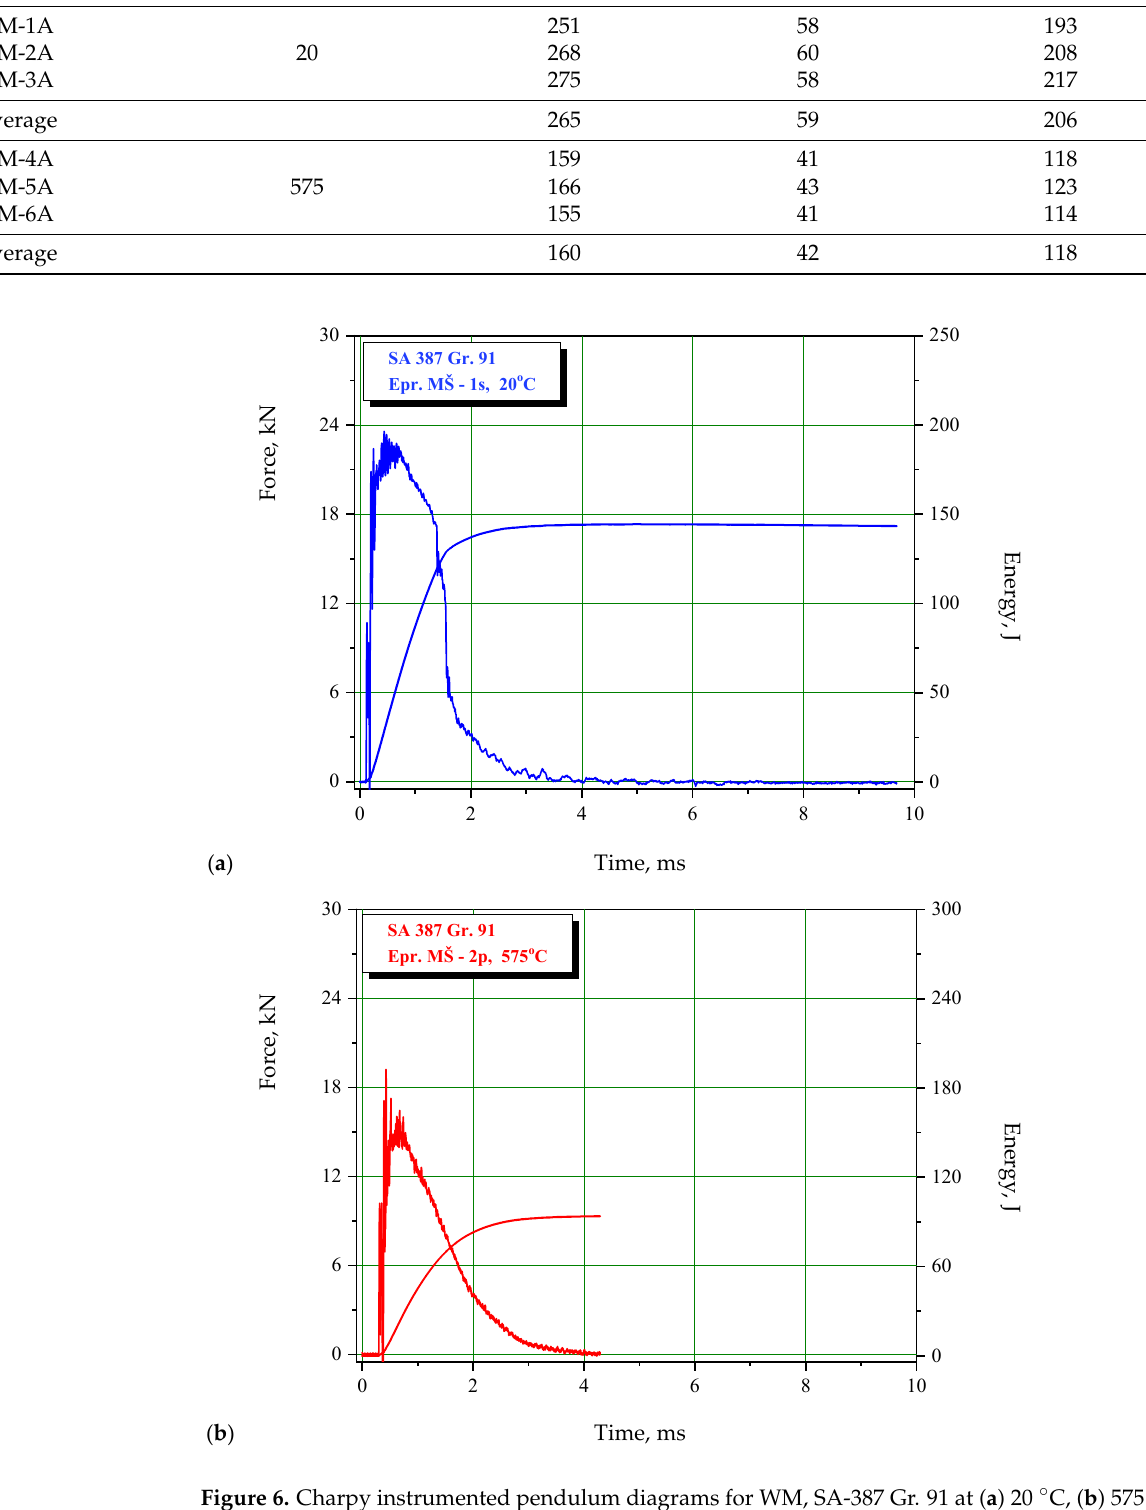
Figure 6. Charpy instrumented pendulum diagrams for WM, SA ‐ 387 Gr. 91 at ( a ) 20 °C, ( b ) 575 °C.